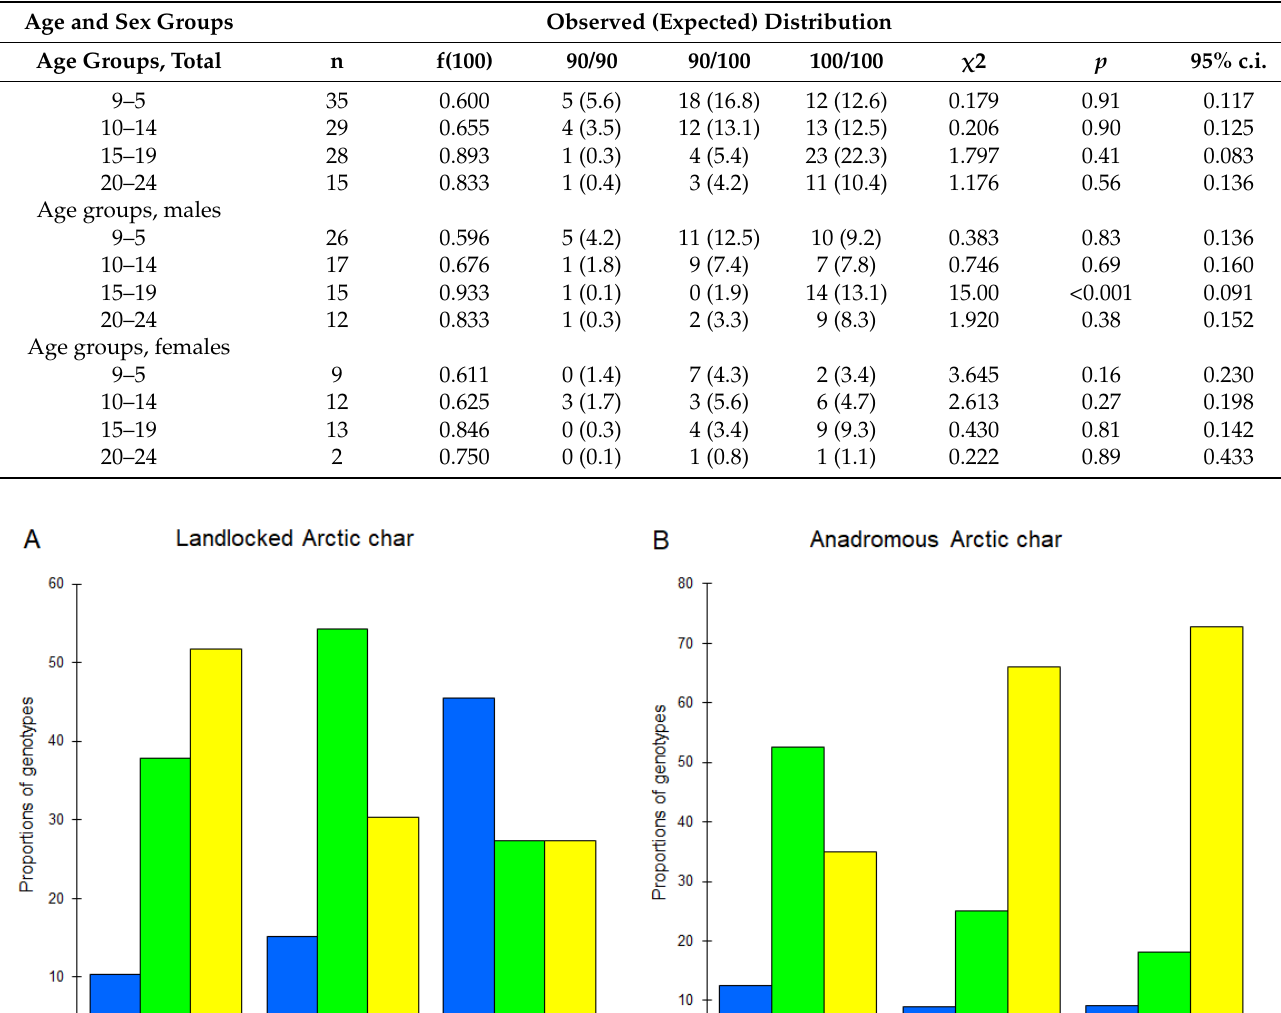
Table 3. Observed allele and genotype frequencies, their expected genotype distribution (in parenthe- ses), deviation from the Castle–Hardy–Weinberg proportions, and the 95% confidence interval at the EST-2* locus in different sex and age groups of anadromous/resident Arctic char from Lake Arkvatn, Svalbard.